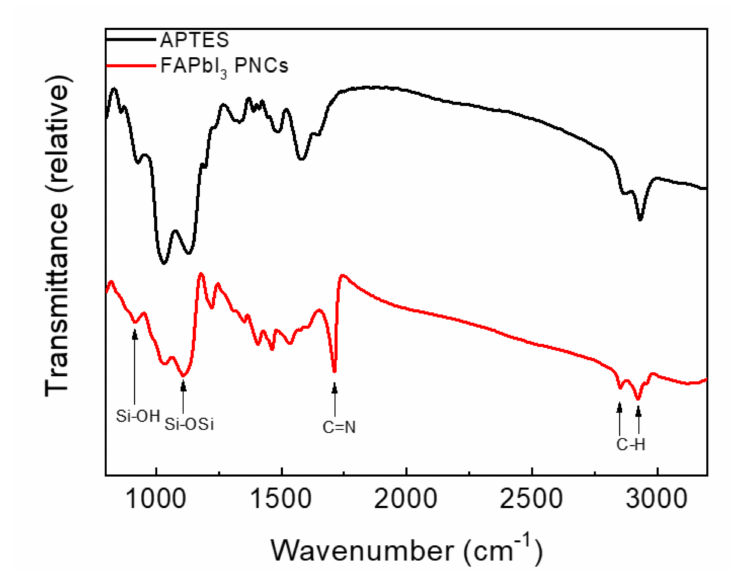
Figure 2. FTIR spectra of APTES and FAPbI 3 NCs. In order to verify that the PNPs embedded in silica, and confirm the real PNCs structure, the morphological features of the PNCs were observed by TEM. HRTEM